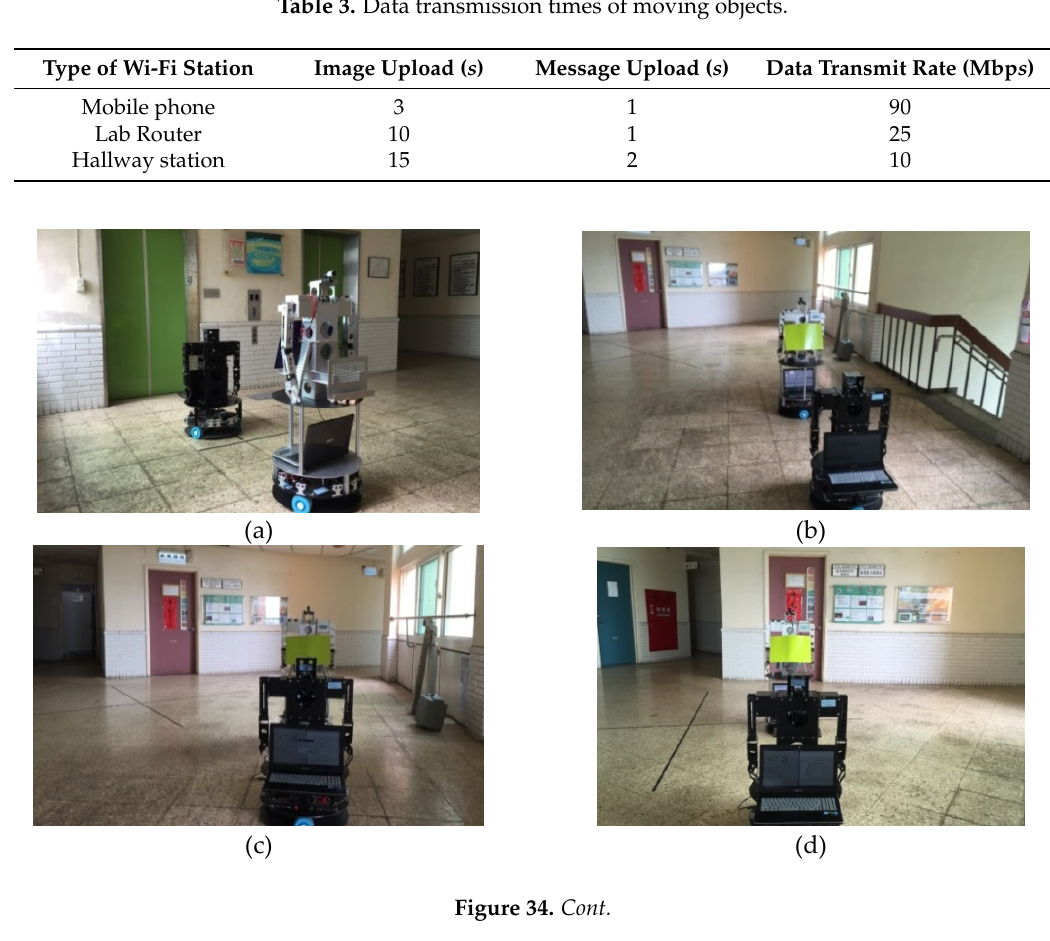
Figure 33. First robot sends alarm message to the second robot. ( a ) Robot 1 initial signal indicators are off; ( b ) Robot 1 sends signal to Robot 2; ( c ) Robot 1 sends e ‐ mail to control center; ( d ) Robot 2 receives alarm message; ( e ) Robot 2 sends e ‐ mail to control center. Table 3. Data transmission times of moving objects.